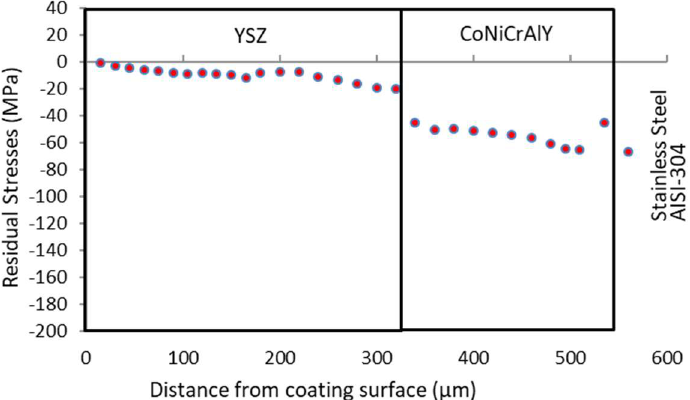
Figure 4. Residual stress is caused by the gas turbine operating the temperature.